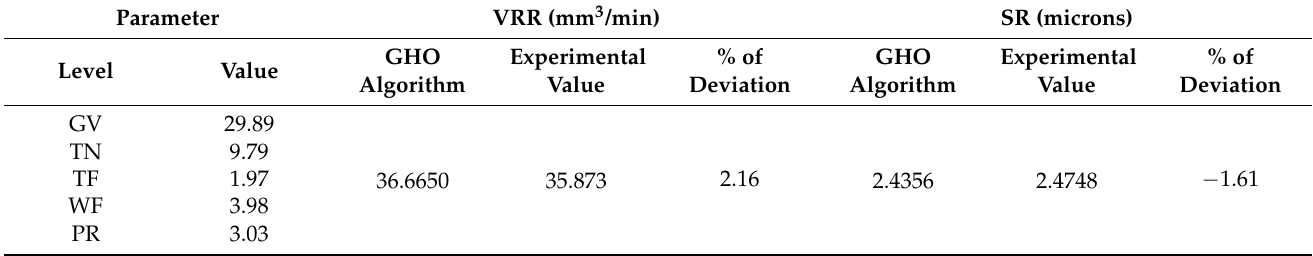
Table 12. Results of the confirmation experiments.